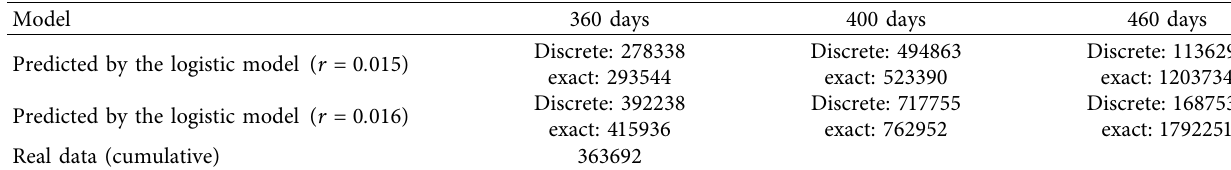
Table 7: Outbreak prediction of cumulative confirmed cases.